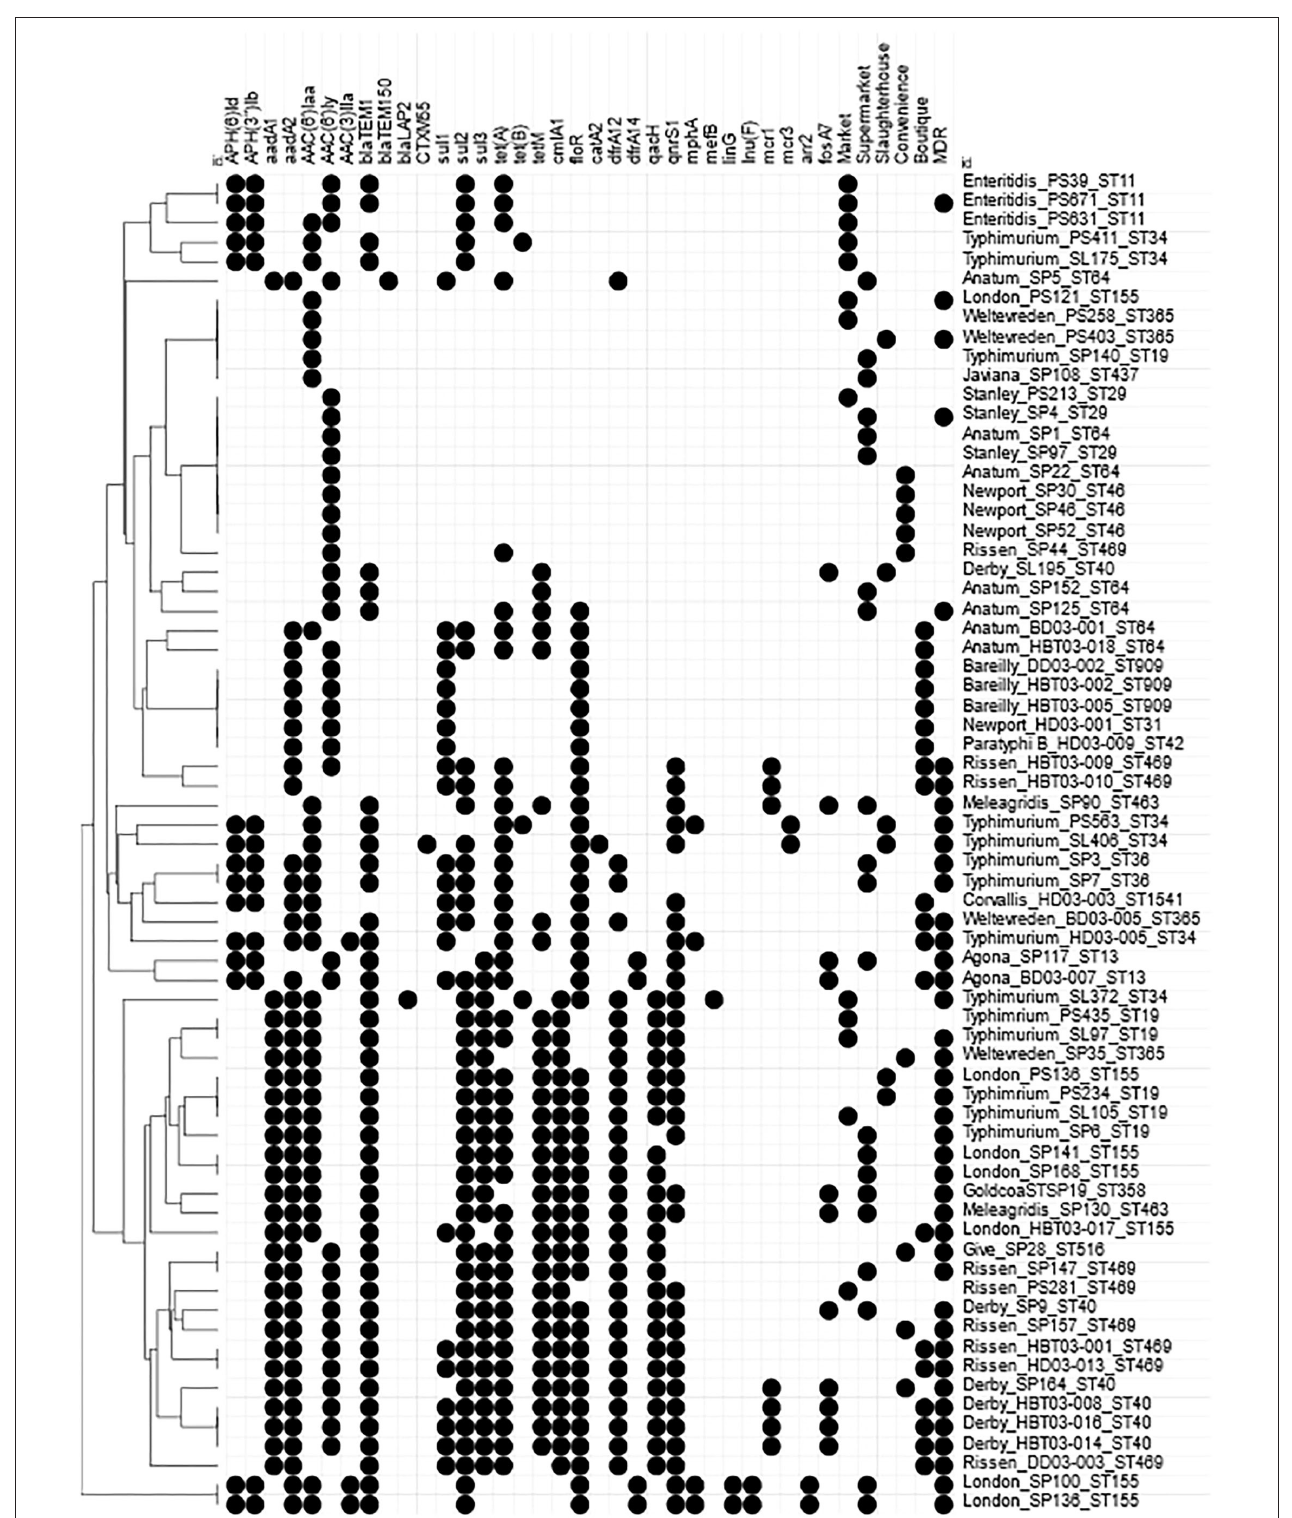
FIGURE 5 | Heatmap of AMR genes within Vietnamese NTS isolates. Presence of Antimicrobial resistance genes within the draft genomes identified by Abricate using CARD and ResFinder databases. Circle indicates presence of match > 90% identity with > 90% coverage of reference gene. AMR genes present in all strains were removed; golS , mdsABC , mktK, and sdiA . MDR indicates an isolate defined as resistant to at least 1 antimicrobial from ≥ 3 different antimicrobial classes. Hierarchical clustered using Euclidian distance.